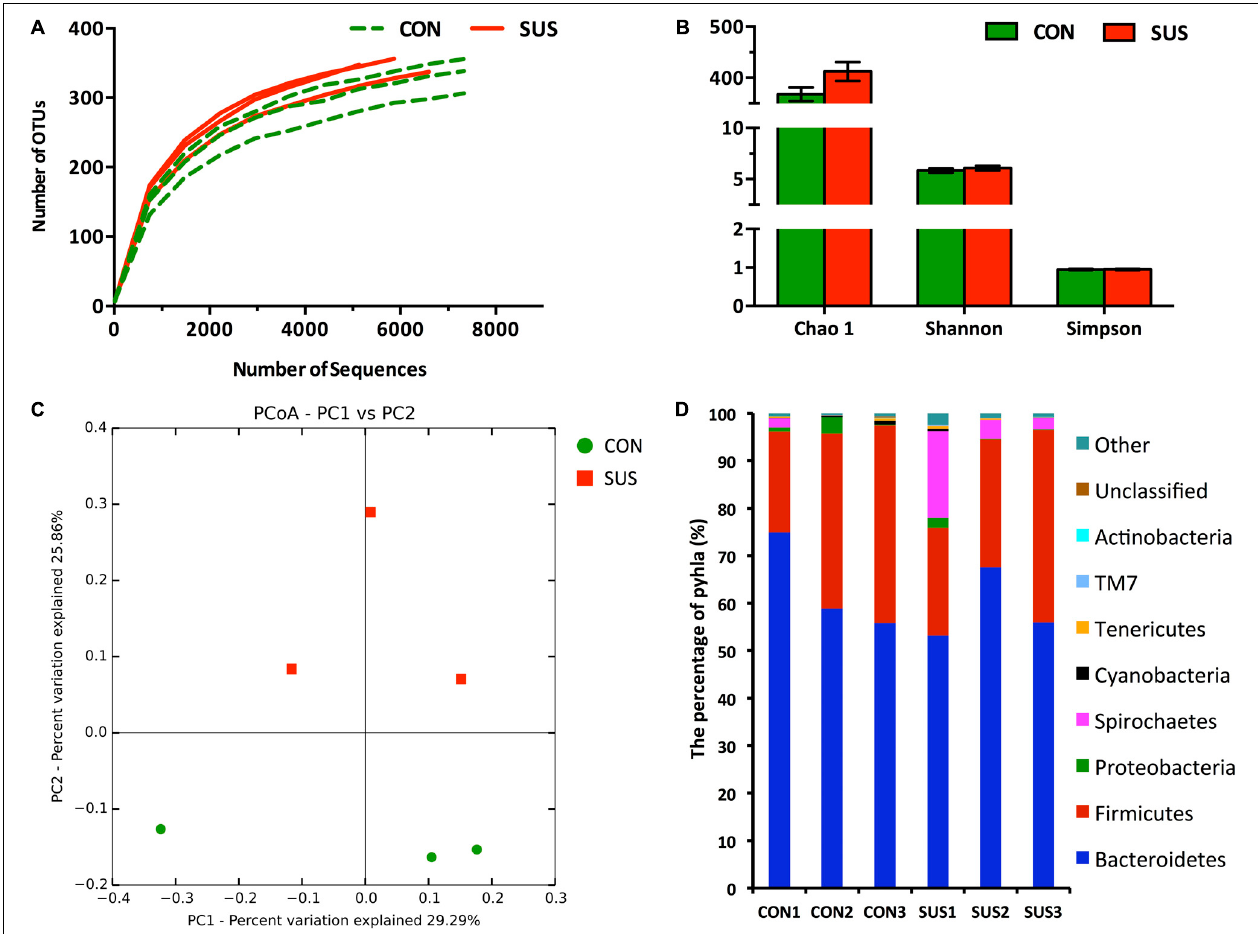
FIGURE 5 | Pyrosequencing analysis of caecal bacteria. (A) Rarefaction curves. (B) Diversity indexes. Values are representative as means ± SEM. (C) Principal coordinates analysis of caecal bacteria at the OTU level. (D) Phylum-level abundance of 16S rRNA gene sequences from the cecum. CON, control group; SUS, simulated weightlessness